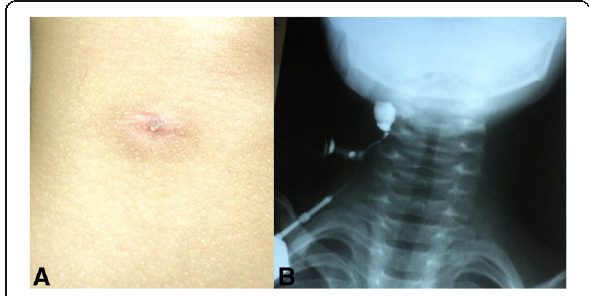
Fig. 1 Branchial fistula. a A photograph of the fistulous opening. b Fistulography; the image shows a tract in the right side of the neck with distal